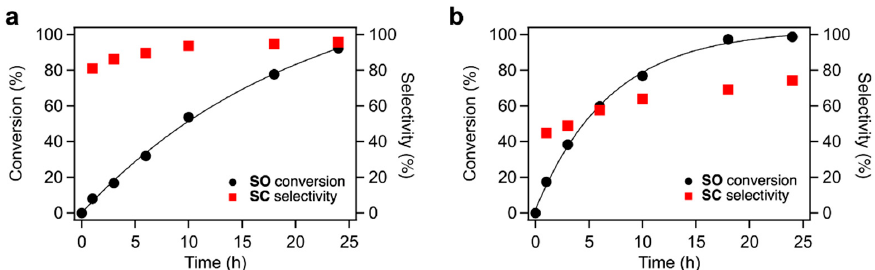
Figure 3. Time courses of SO conversion in CO 2 fixation to SO using ( a ) TBA-Ta 1 Nb 5 and ( b ) TBA- Ta 6 as the catalysts. Reaction condition: catalyst loading = 10 µmol, SO = 1.2 mL (ca. 10 mmol), 100% CO 2 = 0.1 MPa, temperature = 100 °